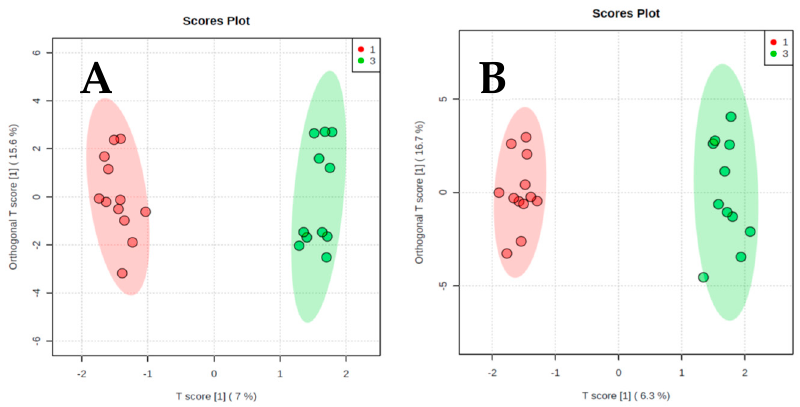
Figure 2. Orthogonal projections to latent structures discriminant analysis. ( A ) Cachectic patients and non-cachectic patients. Urinary Metabolites only. ( B ) Cachectic and non-cachectic patients. Urinary metabolites and information on fat and muscle area from CT scans.